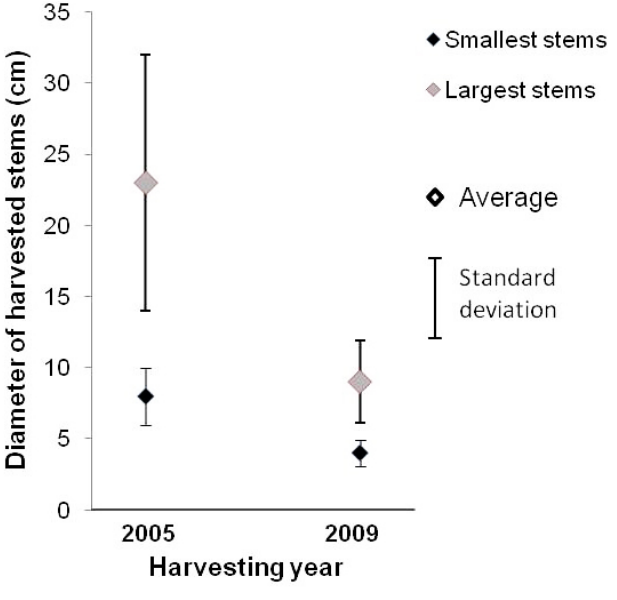
Fig. 5 . Size of harvested stems in 2005 and 2009 according to 28 woodcutters (average and standard deviation).